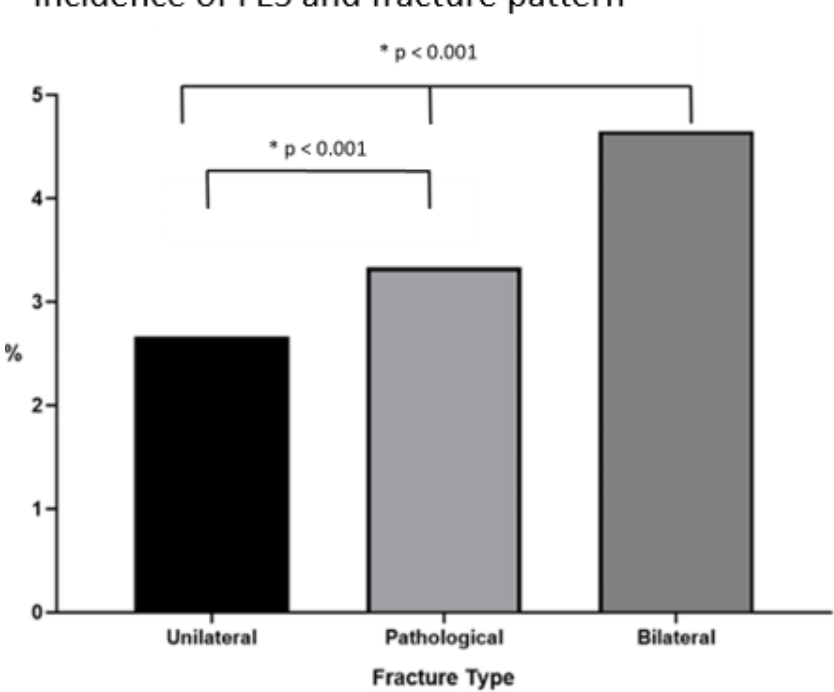
Figure 3. Association between the injury pattern of long bone fractures (femur) and the incidence of FES.